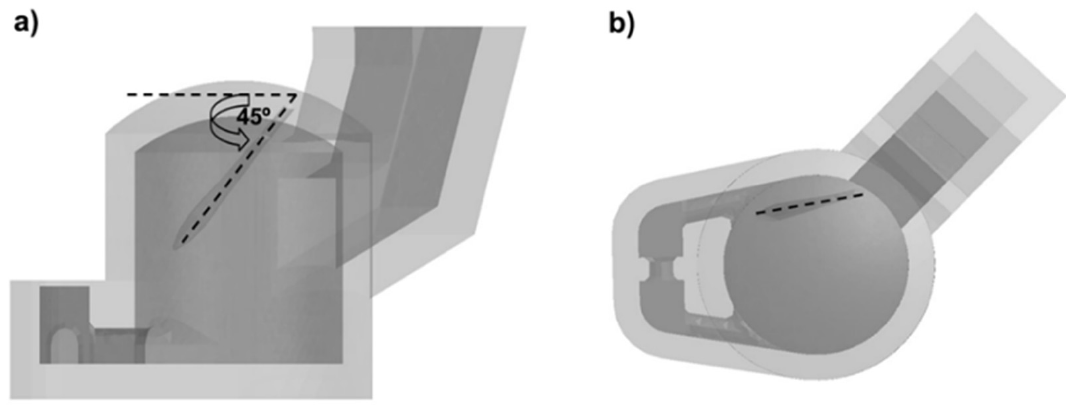
Figure 4. Angle and position of the burner, ( a ) front view and ( b ) top view.